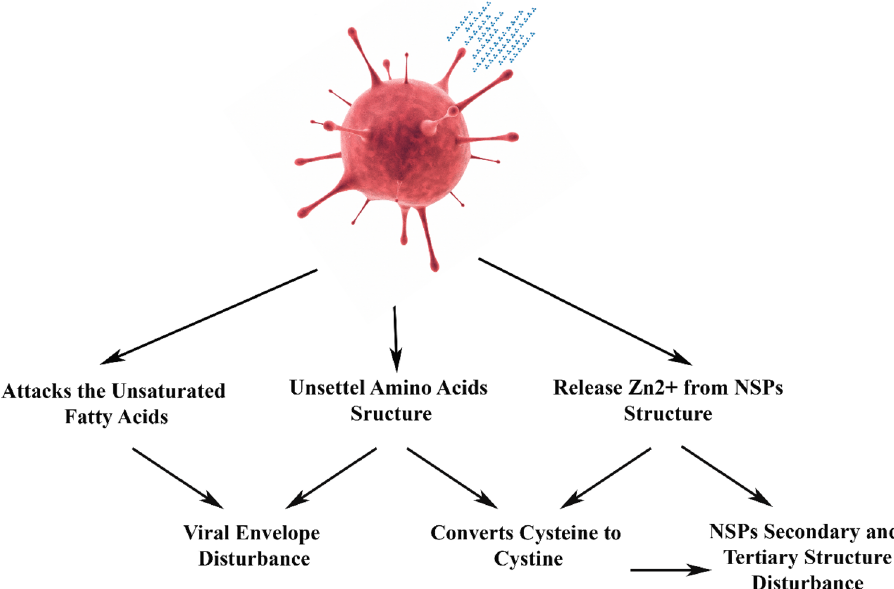
Figure 1. Schematic diagram of ozone destruction mechanism over